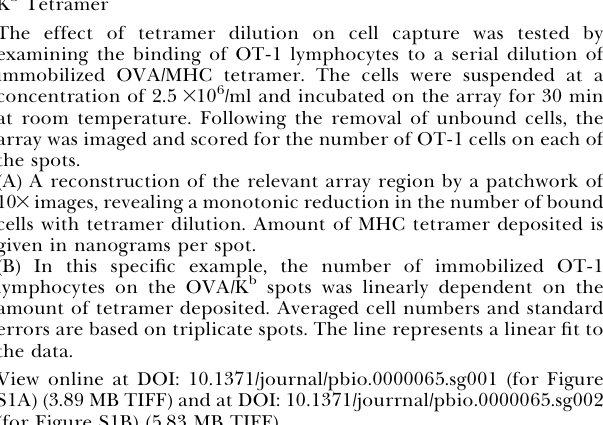
Protocol S1. Online Protocol for the MHC Cellular